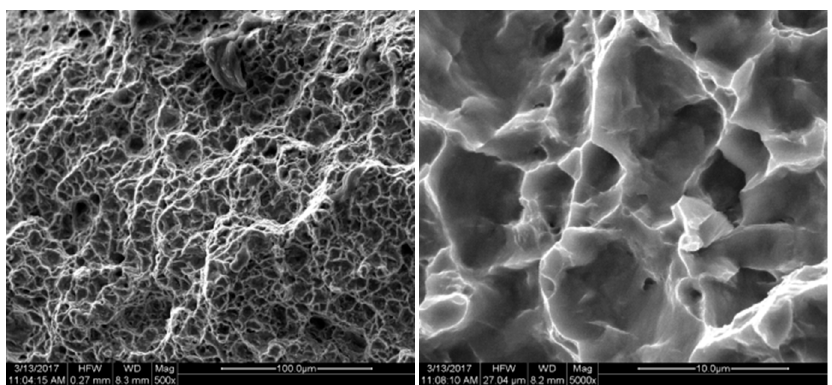
Figure 17. X-axis fracture under the tension speed of 60 μ m/min.